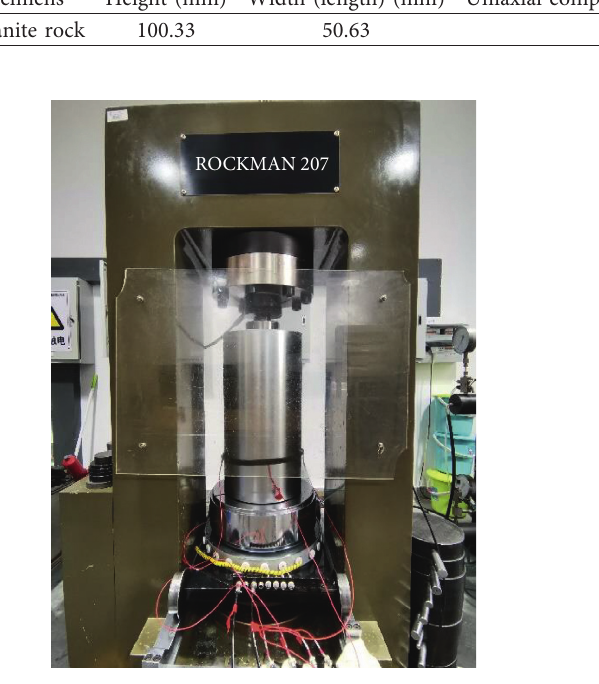
Figure 1: Loading